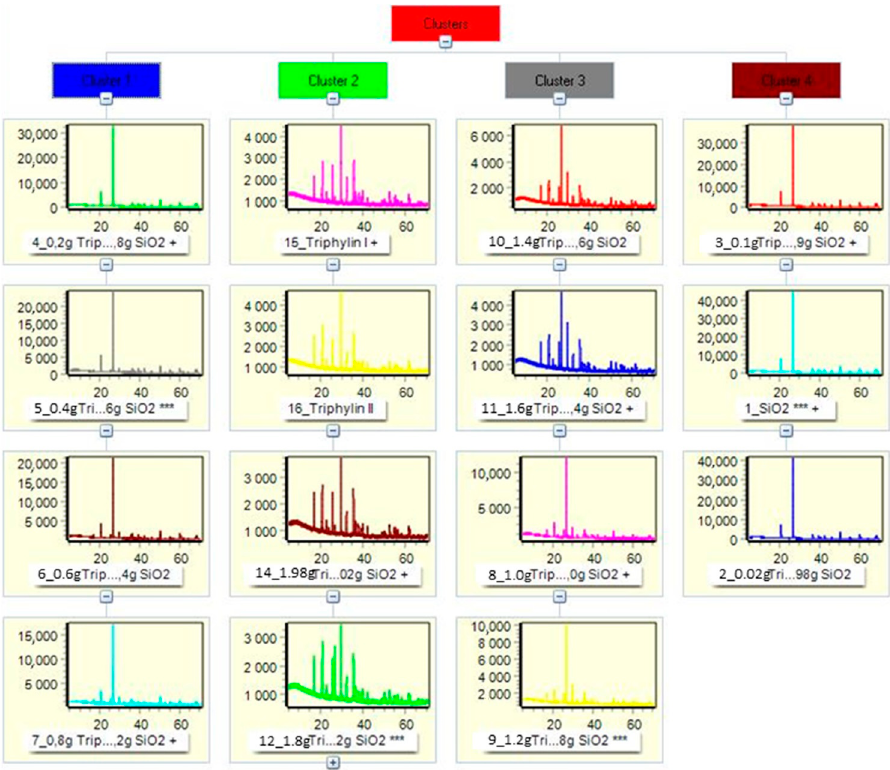
Figure 14. XRD patterns belonging to the respected determined clusters with different triphylite– quartz contents.